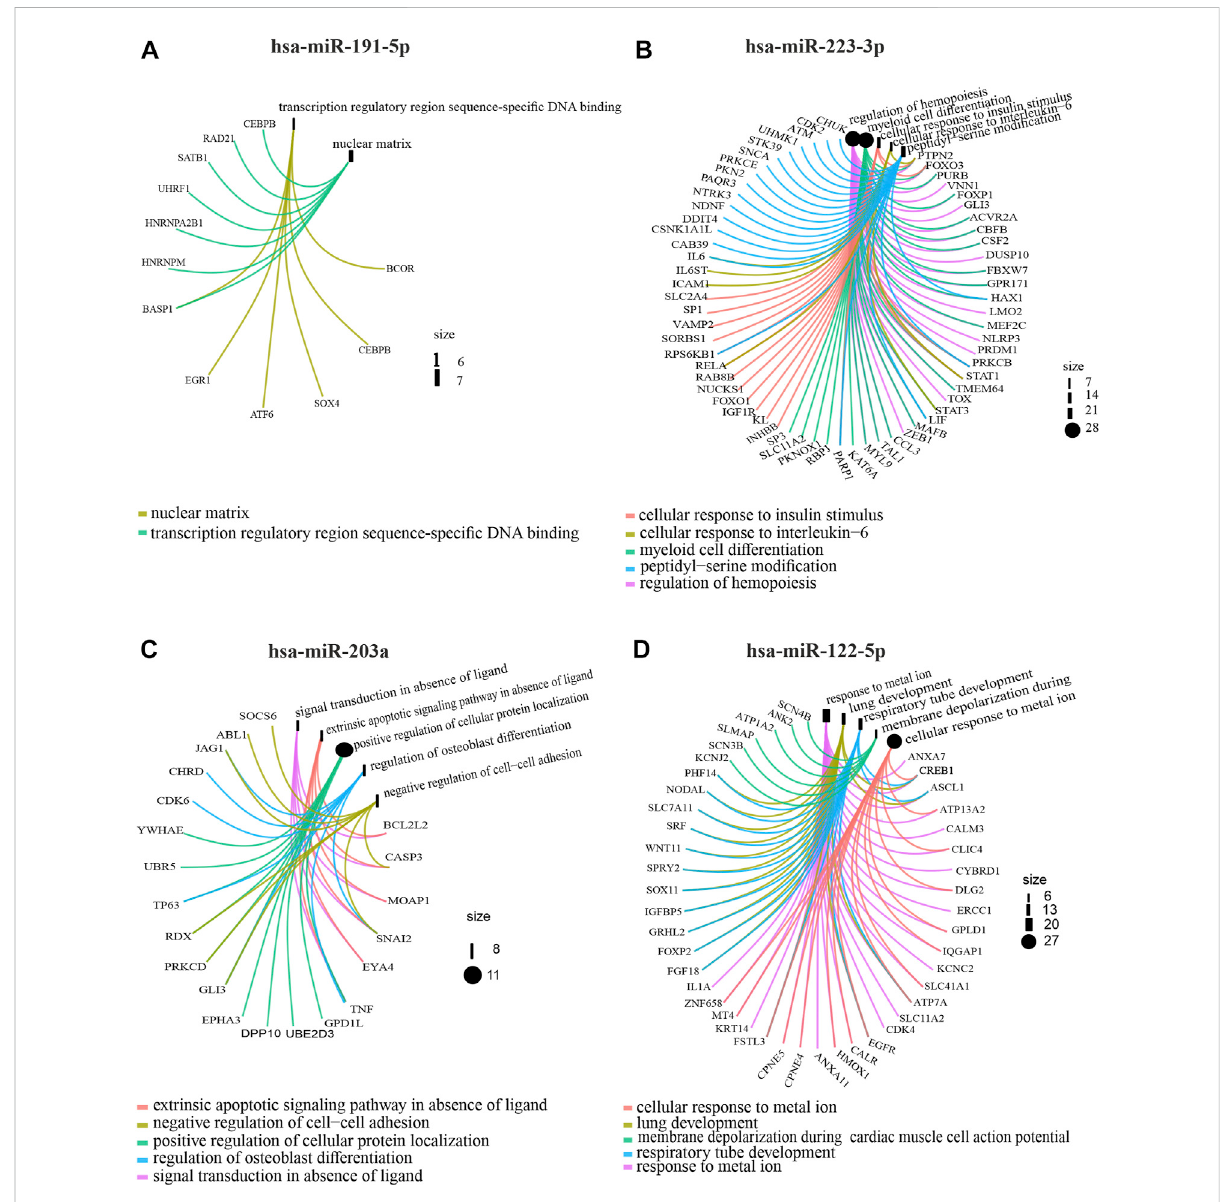
GeneOntologyanalysisshowingcircosplotsoftop5enrichedbiologicalprocessesandcandidatetargetgenesregulatedbyexosomalmiRNAs inprimaryUM-exoscomparedtometastaticUM-exos.Twomostupregulated:hsa-miR-191-5p (A) ,hsa-miR-223-3p (B) and2mostdownregulated: hsa-miR-203a (C) and hsa-miR-122-5p (D) miRNA are shown. Target genes involved in the particular GO termsare depicted by colored connecting lines. The size of a node corresponds to number of genes enriched in given GO term.